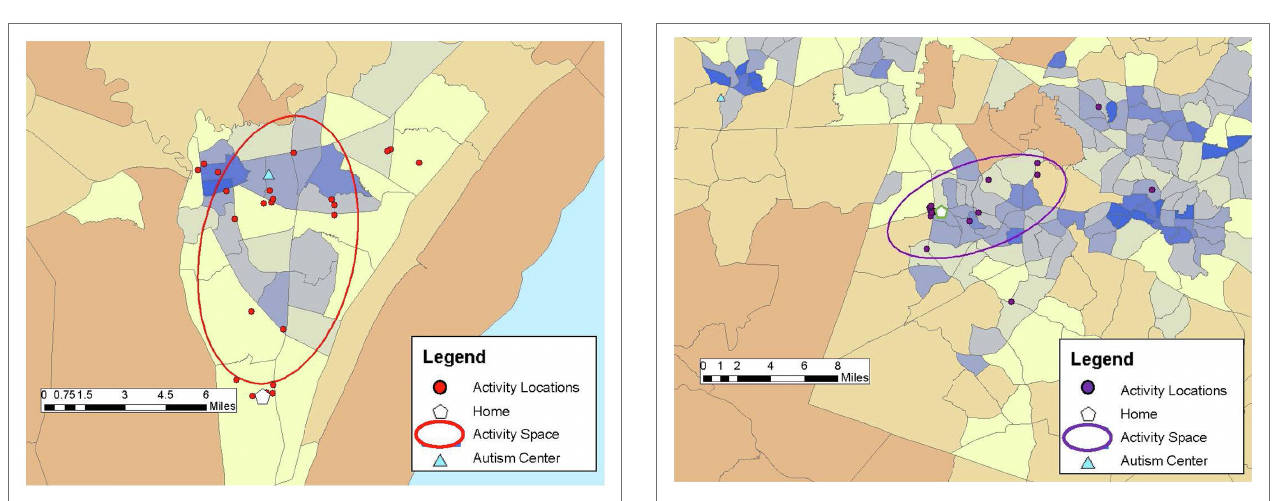
FIGURE 3 | Sherri’s activity space (45.22 mi 2 ) shows both the wide dispersement and a large number of locations visited throughout her